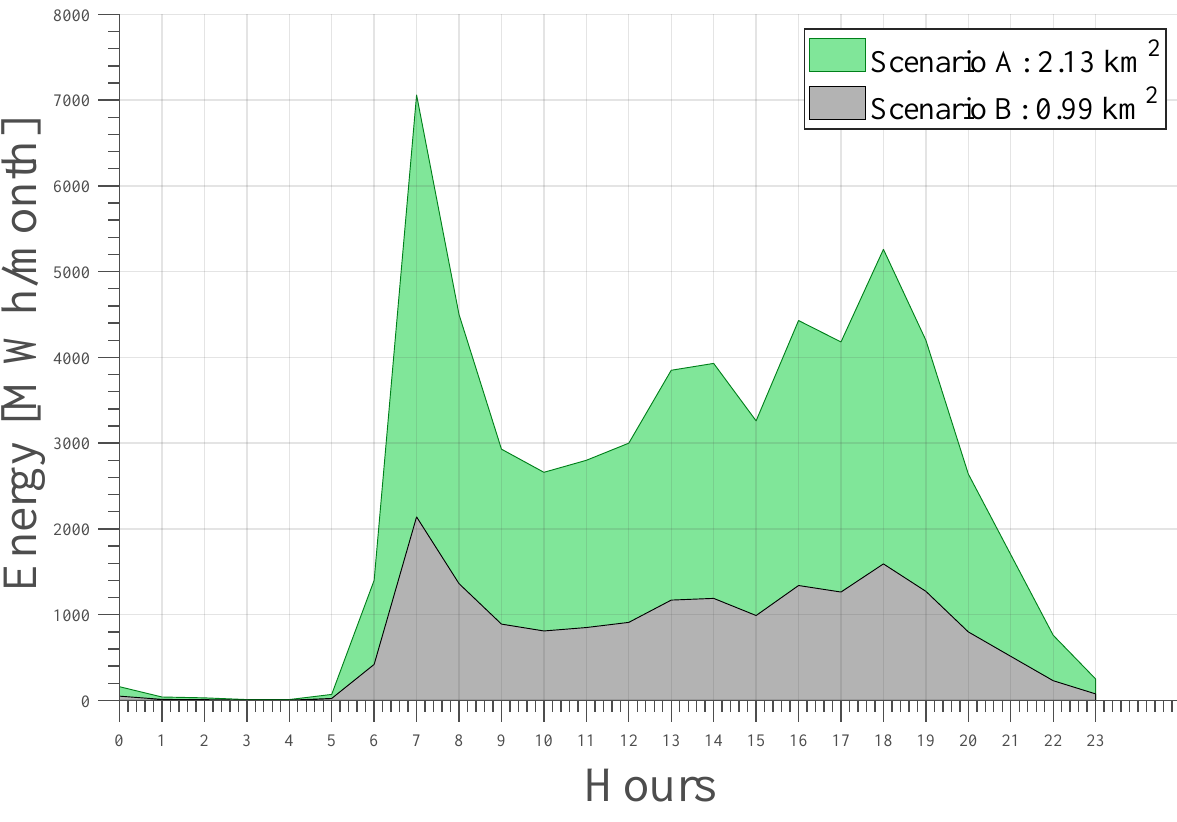
Figure 12. Energy consumption from the massive introduction of electric